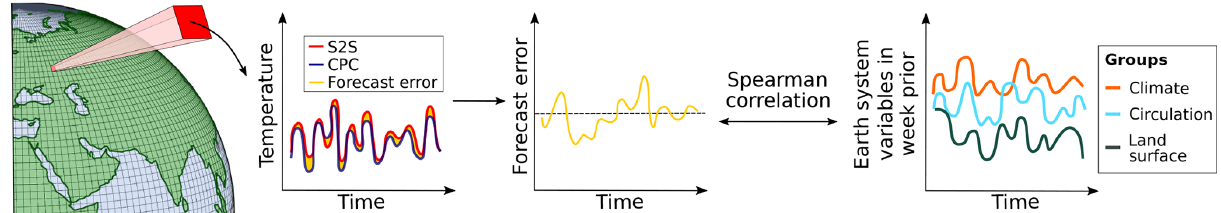
Figure 1. Schematic summary of the workflow. Within each grid cell, we calculate weekly averages of temperature forecast errors (lead times 1–6 weeks) and then compute their Spearman correlations with Earth system variables averaged across the week prior to the forecast